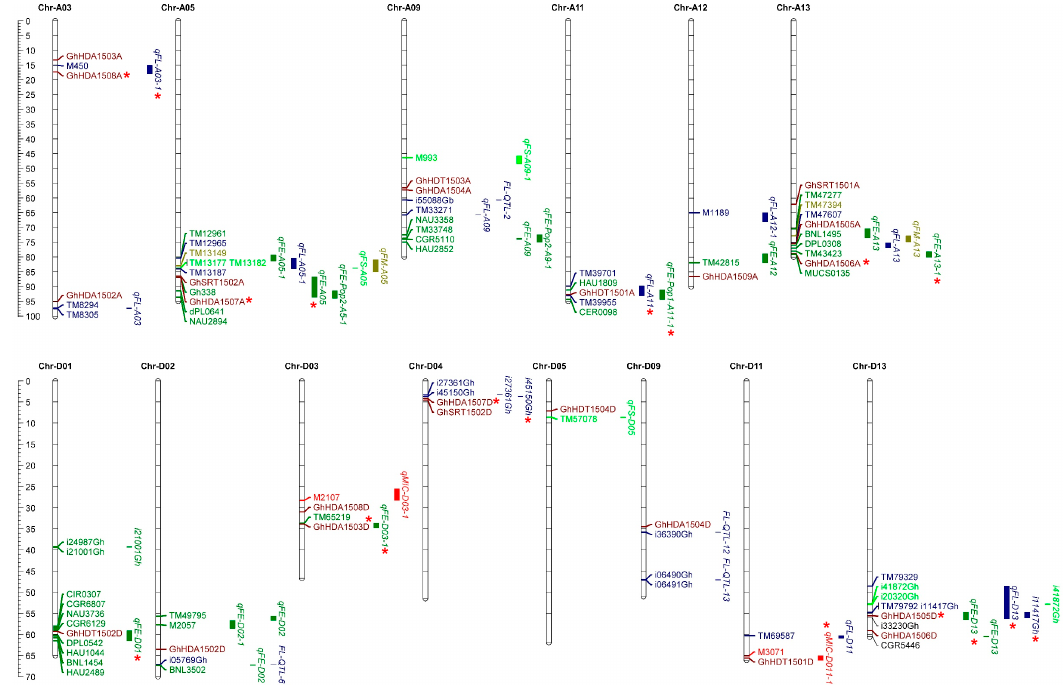
Figure 7. Distribution of co-localized HDACs on the chromosomes of the A and D genomes of G. hirsutum . The scale represents the physical position of genes and quantitative trait locus (QTL)-linked markers in megabases (Mb). QTLs and single-nucleotide polymorphisms (SNPs) related to fiber length (FL), fiber elongation (FE), fiber micronaire (FM), fiber strength (FS), and fiber uniformity (FU) are shown. Asterisks (*) indicate the G. hirsutum HDACs that were co-localized with QTLs/SNPs of different traits of fiber.